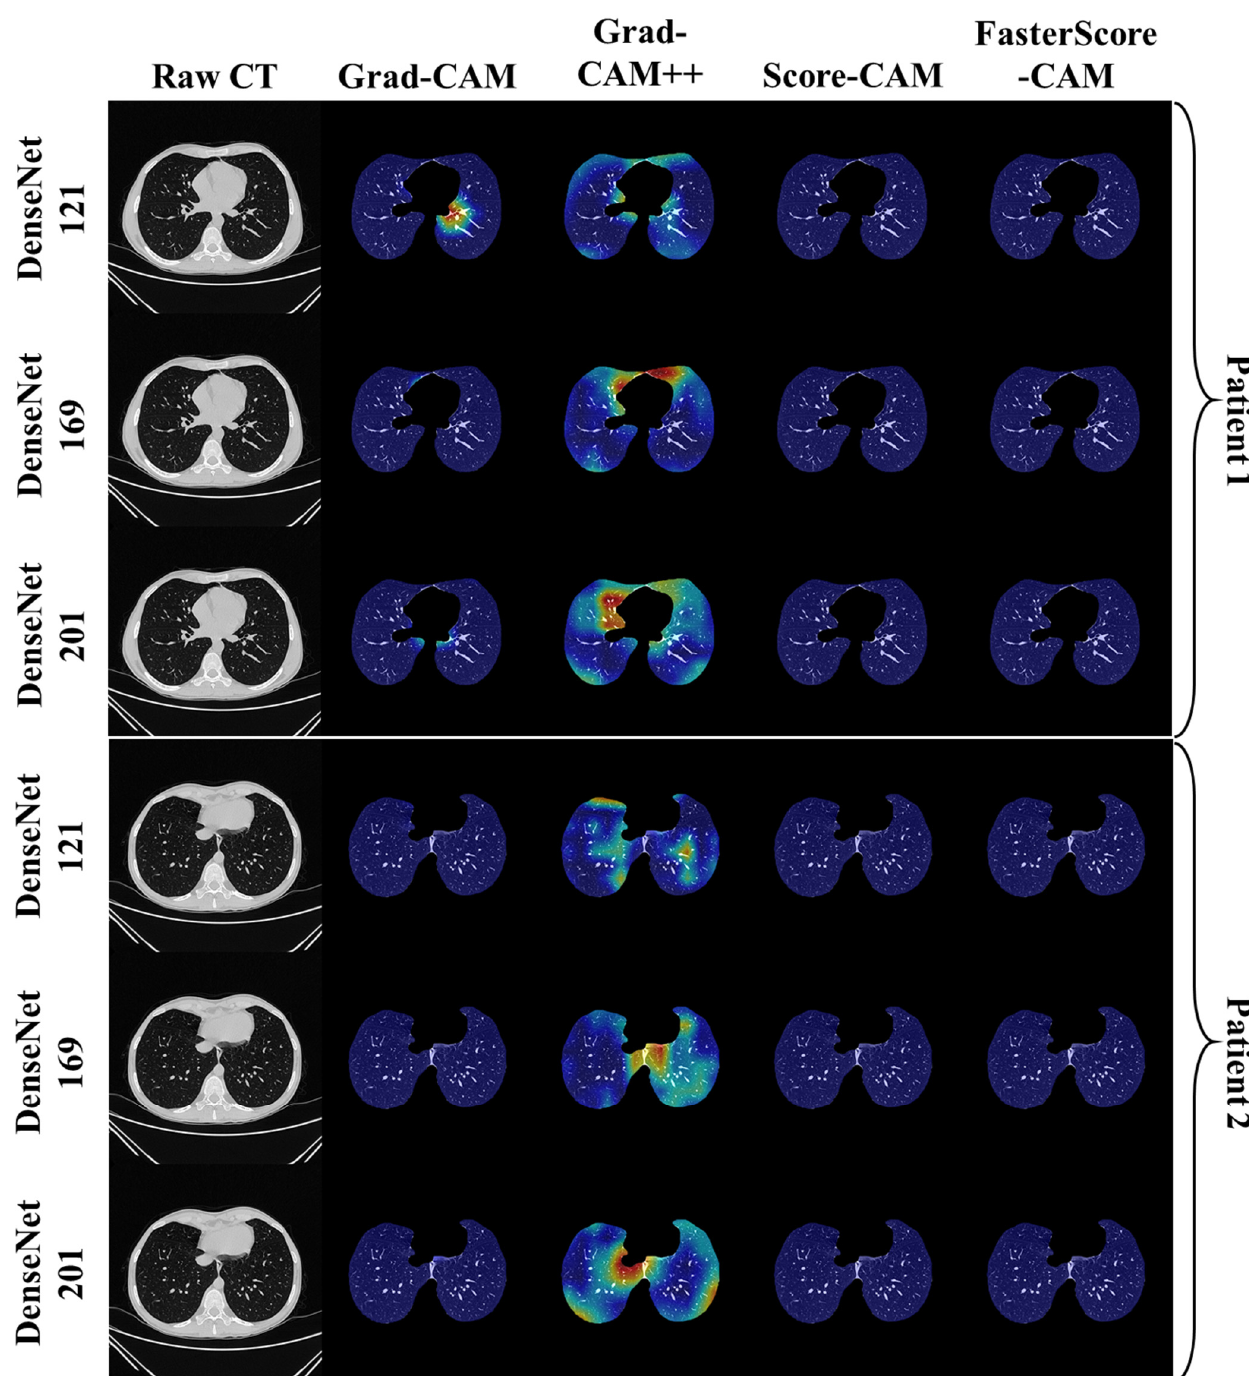
Figure 14. Heatmap using four CAM techniques using three kinds of DenseNet classifiers on control images. The top row is the CT slice for patient 1, and the bottom row is the CT slice for patient